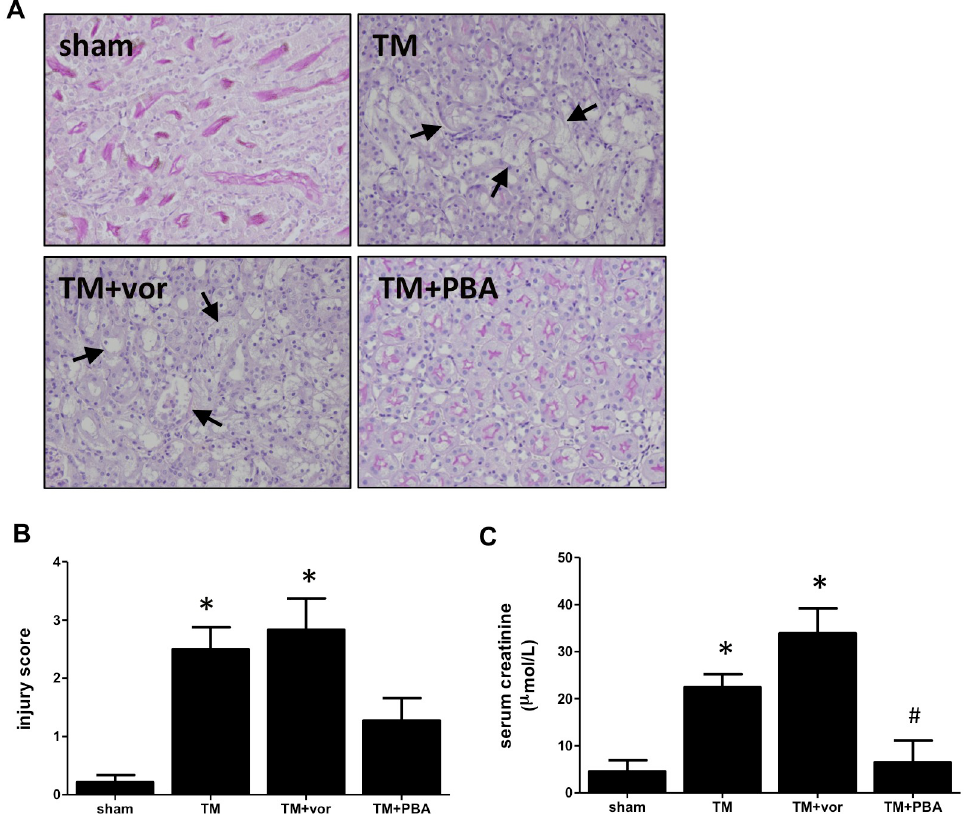
Fig 4. Wild type mice were given tunicamycin (TM; 0.5 mg/kg I.P) for three days with or without vorinostat (vor; 50 mg/kg/day) or 4-phenylbutyrate (PBA; 1 g/kg/day). (A) Kidneys were PAS stained to examine structural damage in the pars recta. Damage is indicated with arrows. (B) Kidney injury scores demonstrate TM caused significant damage in the pars recta, with TM+vor-treated mice having similar levels of damage. (C) Serum creatinine levels were increased in TM- treated mice. Vorinostat did not affect TM-induced creatinine levels, which was prevented by PBA. � , p < 0.05 vs sham; #, p < 0.05 vs TM.